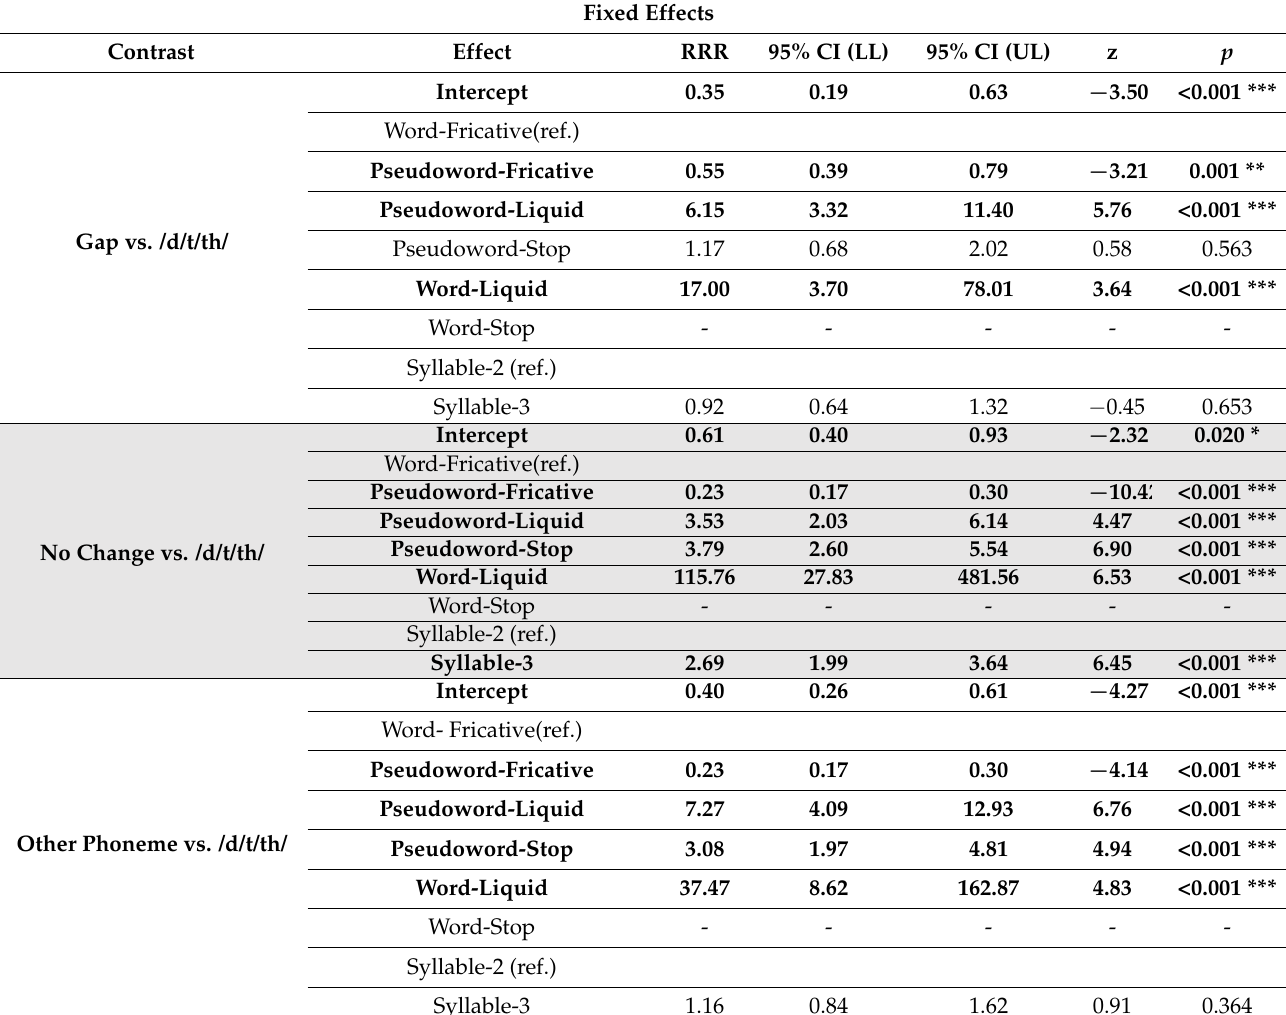
Table 4. Results of the follow-up mixed effects multinomial logistic regression, with Word-Fricative as the reference category for the Block Type-Manner of Articulation condition. Please note that the random effects covariance parameters are not displayed, since they are identical to Table 3. Significant fixed effects/interactions are depicted in bold font and indicated with asterisks as follows: * p < 0.05, ** p < 0.01, *** p <